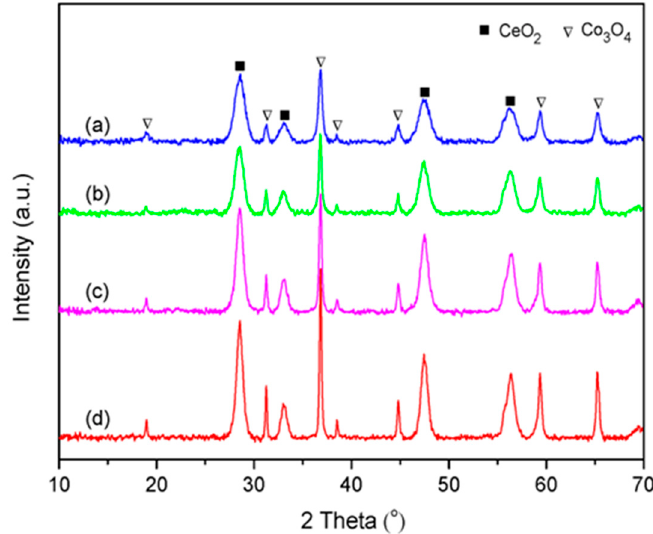
Figure 2. XRD patterns of the CoCe–X catalysts: ( a ) CoCe–MA; ( b ) CoCe–CA; ( c ) CoCe–GA; and ( d ) CoCe–TA.